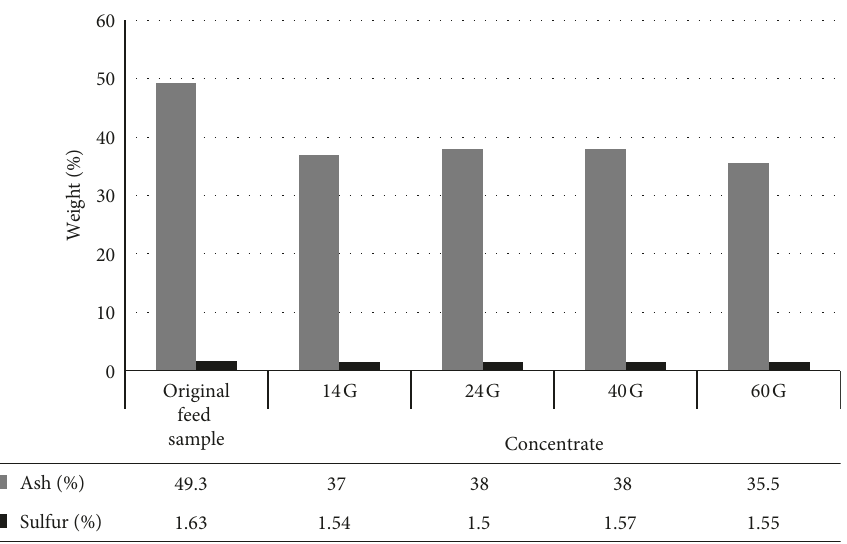
Figure 8: Sample-C2 Knelson gravity ash % and sulfur % analysis chart (